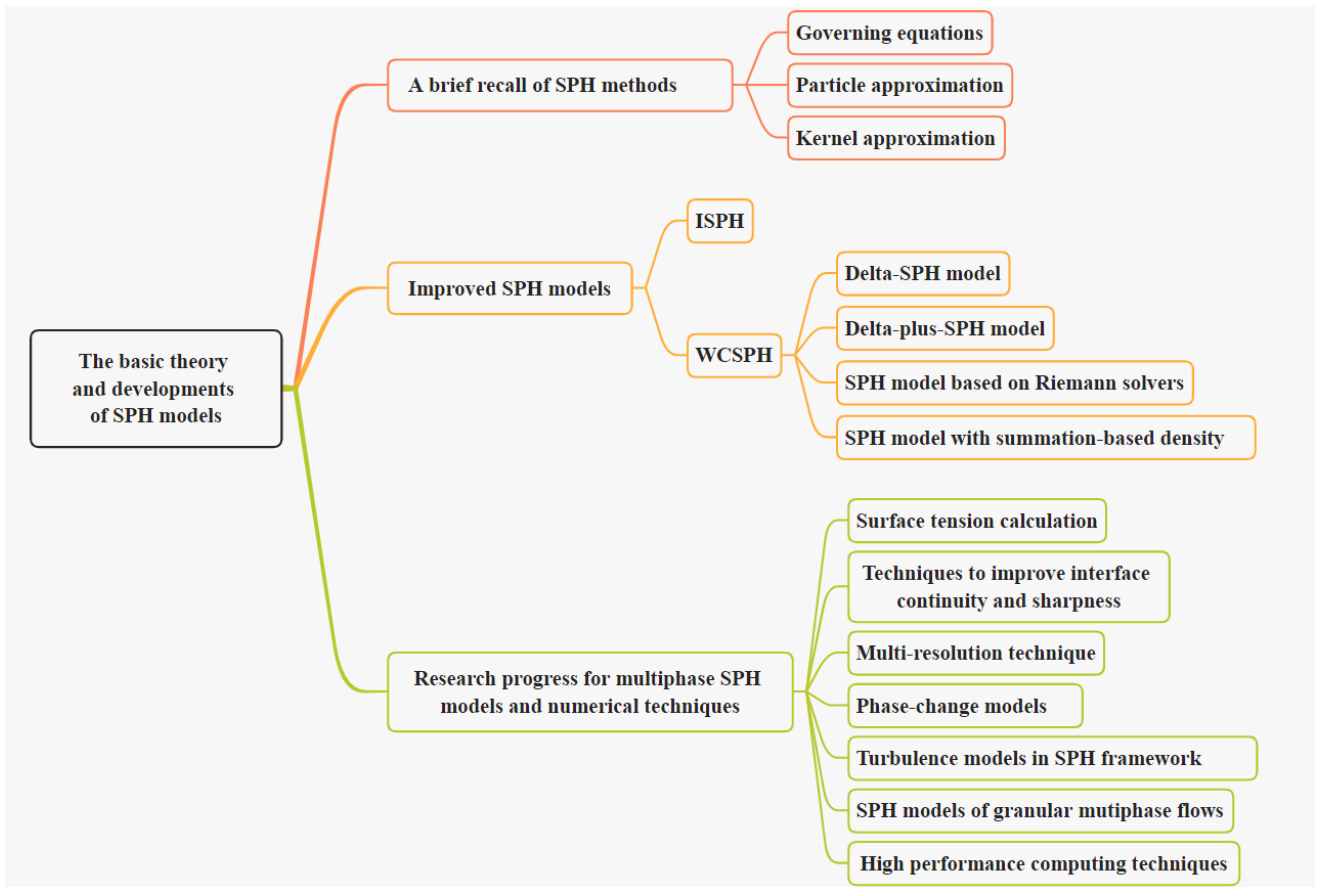
Figure 2. The framework of the section for reviewing the basic theory and developments of SPH